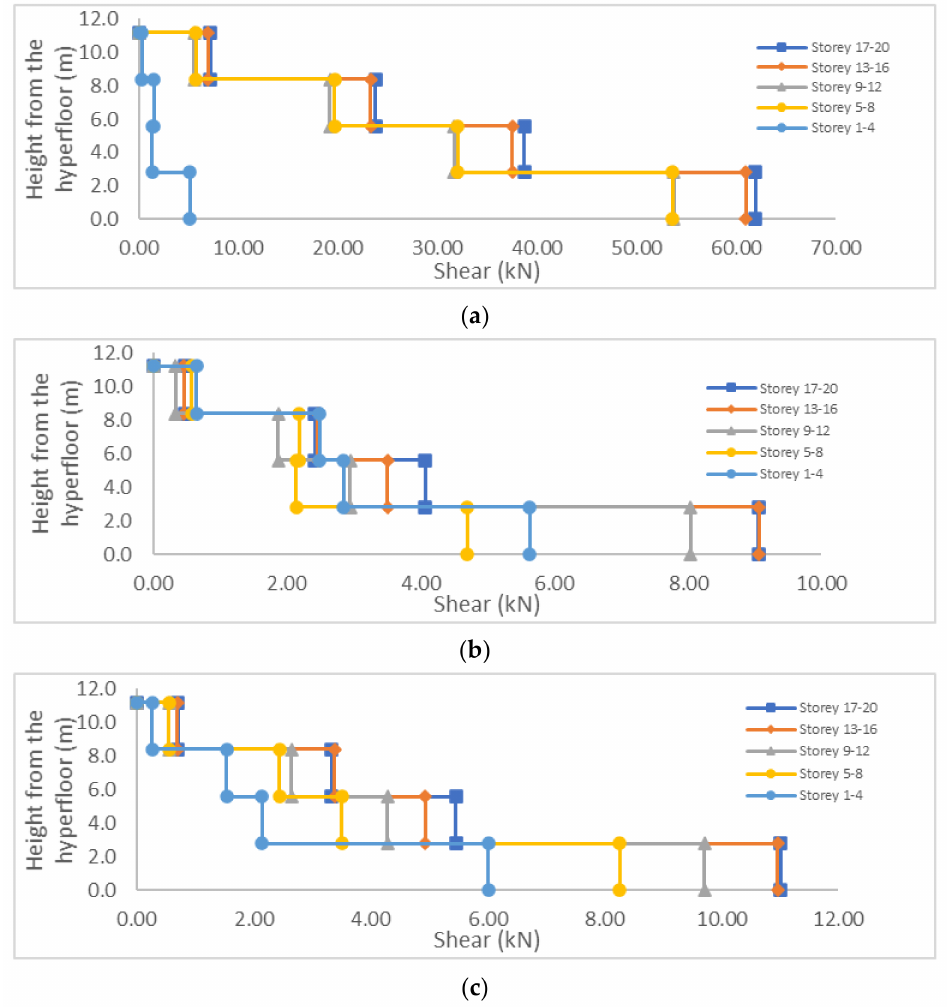
Figure 13. Shear experienced by the shearwall segments of the long modules under factored gravity- load combination 1.25 D + 1.5 L + 1.0 S. The end shearwall segments of 3.475 m length are shown in ( a ), the segment of 3.0 m length are shown in ( b ) and the segment of 3.5 m length are shown in ( c